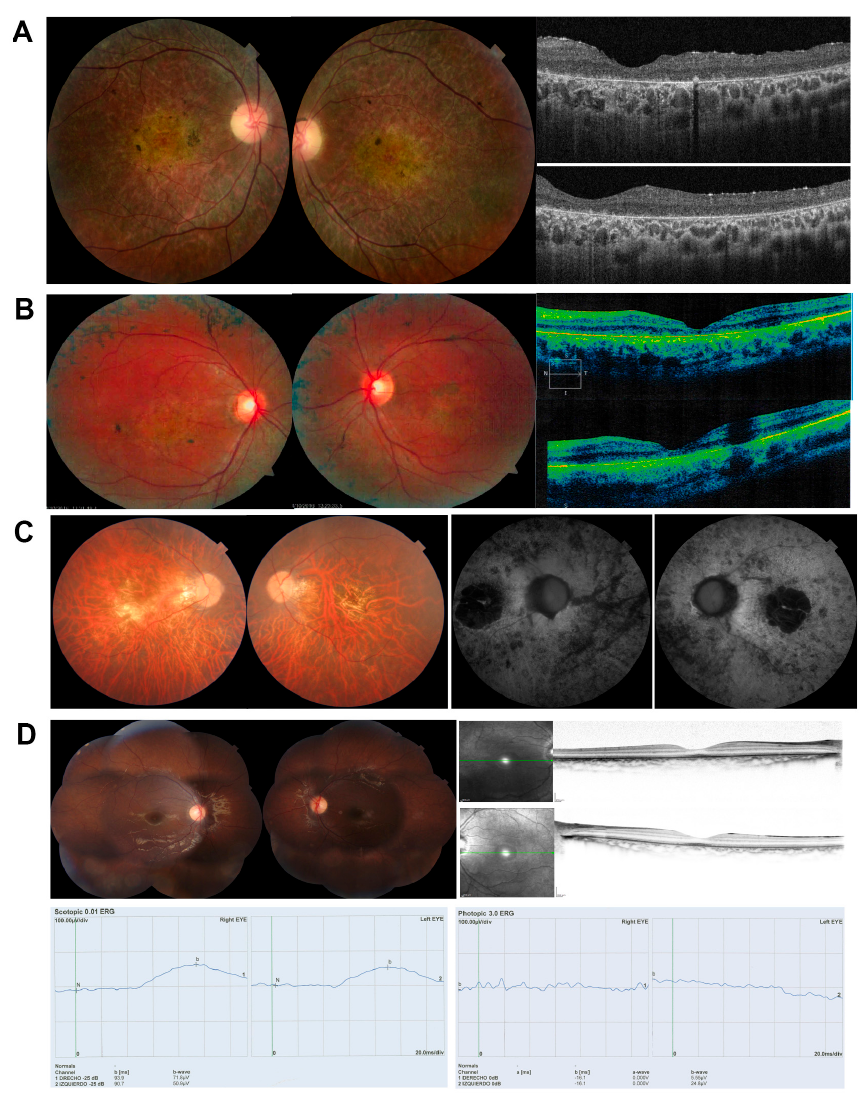
Figure 1. Ocular phenotypes of patients analyzed in this study, with fundus examination, autofluorescence imaging, OCT imaging and ERGs (if available). ( A ) DBG1, clinically diagnosed of RP; Fundus image showing retinal vascular attenuation, central EPR and retinal atrophy, with peripheral retinal bony spicule hyperpigmentation. OCT shows diffuse retinal thinning, and severe alteration of the external layers. ( B ) DBG2, clinically diagnosed of RP with macular affectation; Fundus showing the central macular area exhibiting hypoautofluorescence corresponding to foveal area. Macular area of granular aspect with points of hyperautofluorescence. There are several scattered parches of hypoautofluorescence located out of vascular arcades at temporal and nasal side; OCT shows preserved foveal morphology and thinning of the macula in both eyes. ( C ) DBG3, clinically diagnosed of RP; Fundus showing tilted disc, peripapilary atrophy, atrophic RPE at the macula with a geographical shape, some vitreous opacities and some bony spicule pigmentation at the fundus equator. The atrophic macular area presents hypoautofluorescence with a small sparing area at the fovea. ( D ) DBG4 clinically diagnosed of Cone-Rod Dystrophy. Both eyes with retinal pigmentary changes and mild central hyperautofluorescence, with normal OCT; ERGs with very reduced scototpic (left) and photopic (right) response.